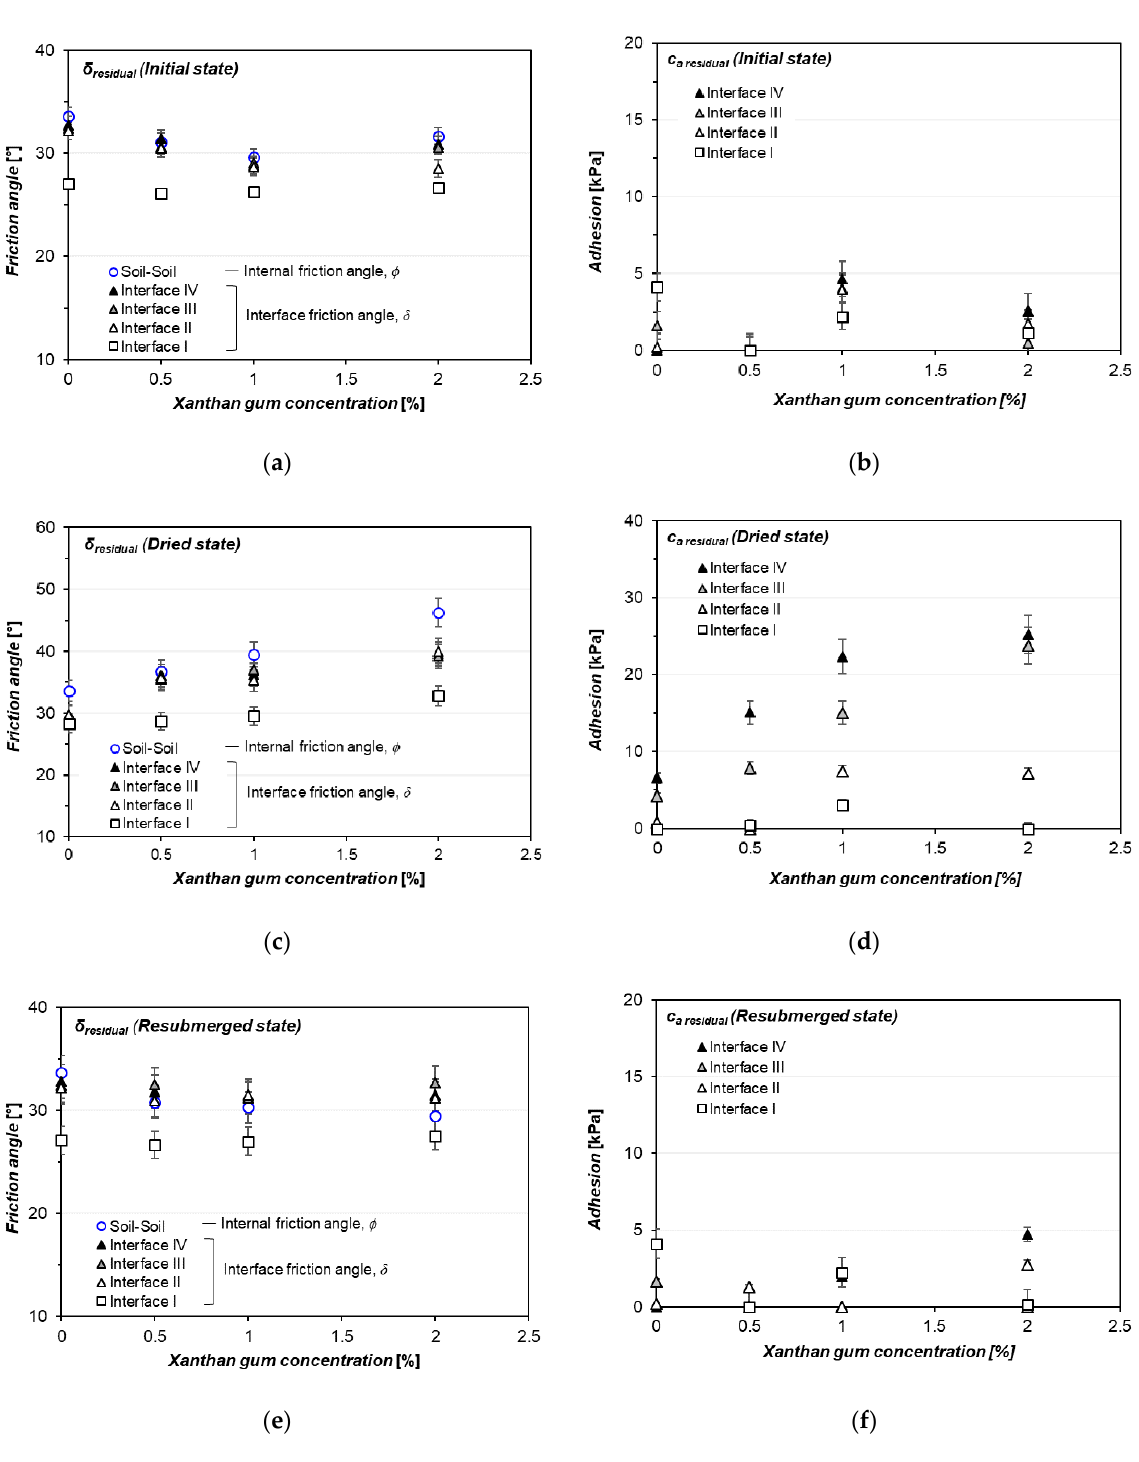
Figure 14. Residual interfacial shear parameters of xanthan gum-treated sand (soil–structure interface): ( a , b ) residual interface friction angle ( δ residual ) and adhesion ( c aresidual ) in initial state, ( c , d ) residual interface friction angle ( δ residual ) and adhesion ( c aresidual ) in dried state, and ( e , f ) residual interface friction angle ( δ residual ) and adhesion ( c aresidual ) in resubmerged state.